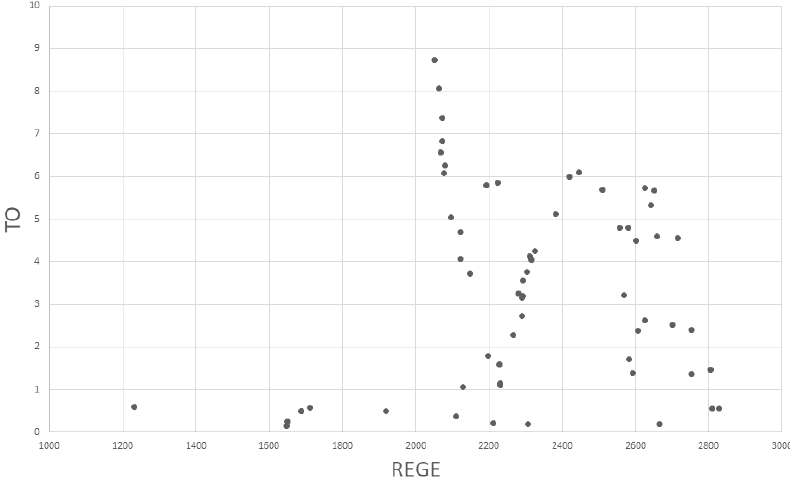
Figure 5. The relationship between the REGE and TO values for each node in the Gulf of Naples food web (Figure 2).